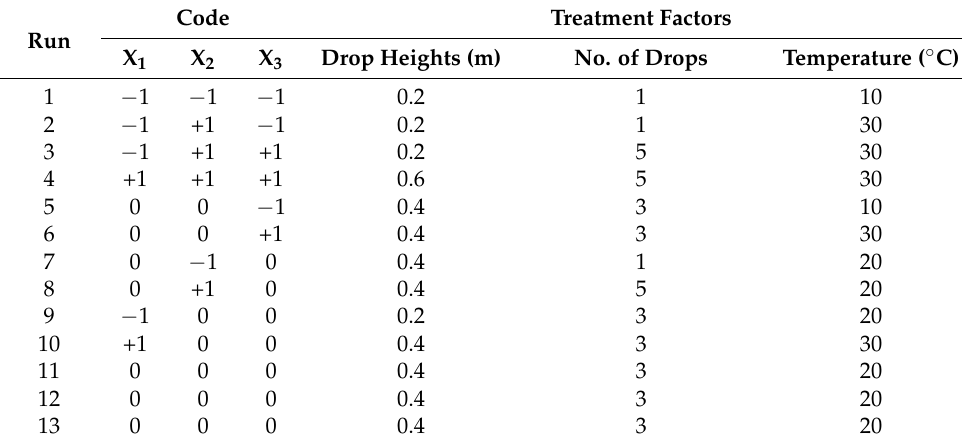
Table 5. Thirteen treatments to verify the predictive model in ‘Glom Sali’ guava impact bruising by simulated impact